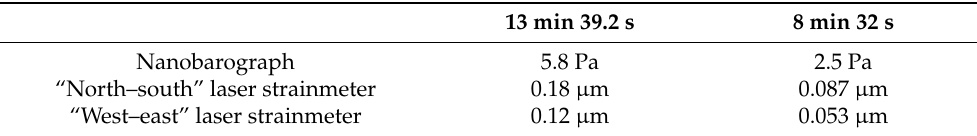
Table 2. Data of spectral processing of records of the laser-interference systems, installed at Schulz Cape, the antipodal passage of Lamb waves near Schultz Cape.